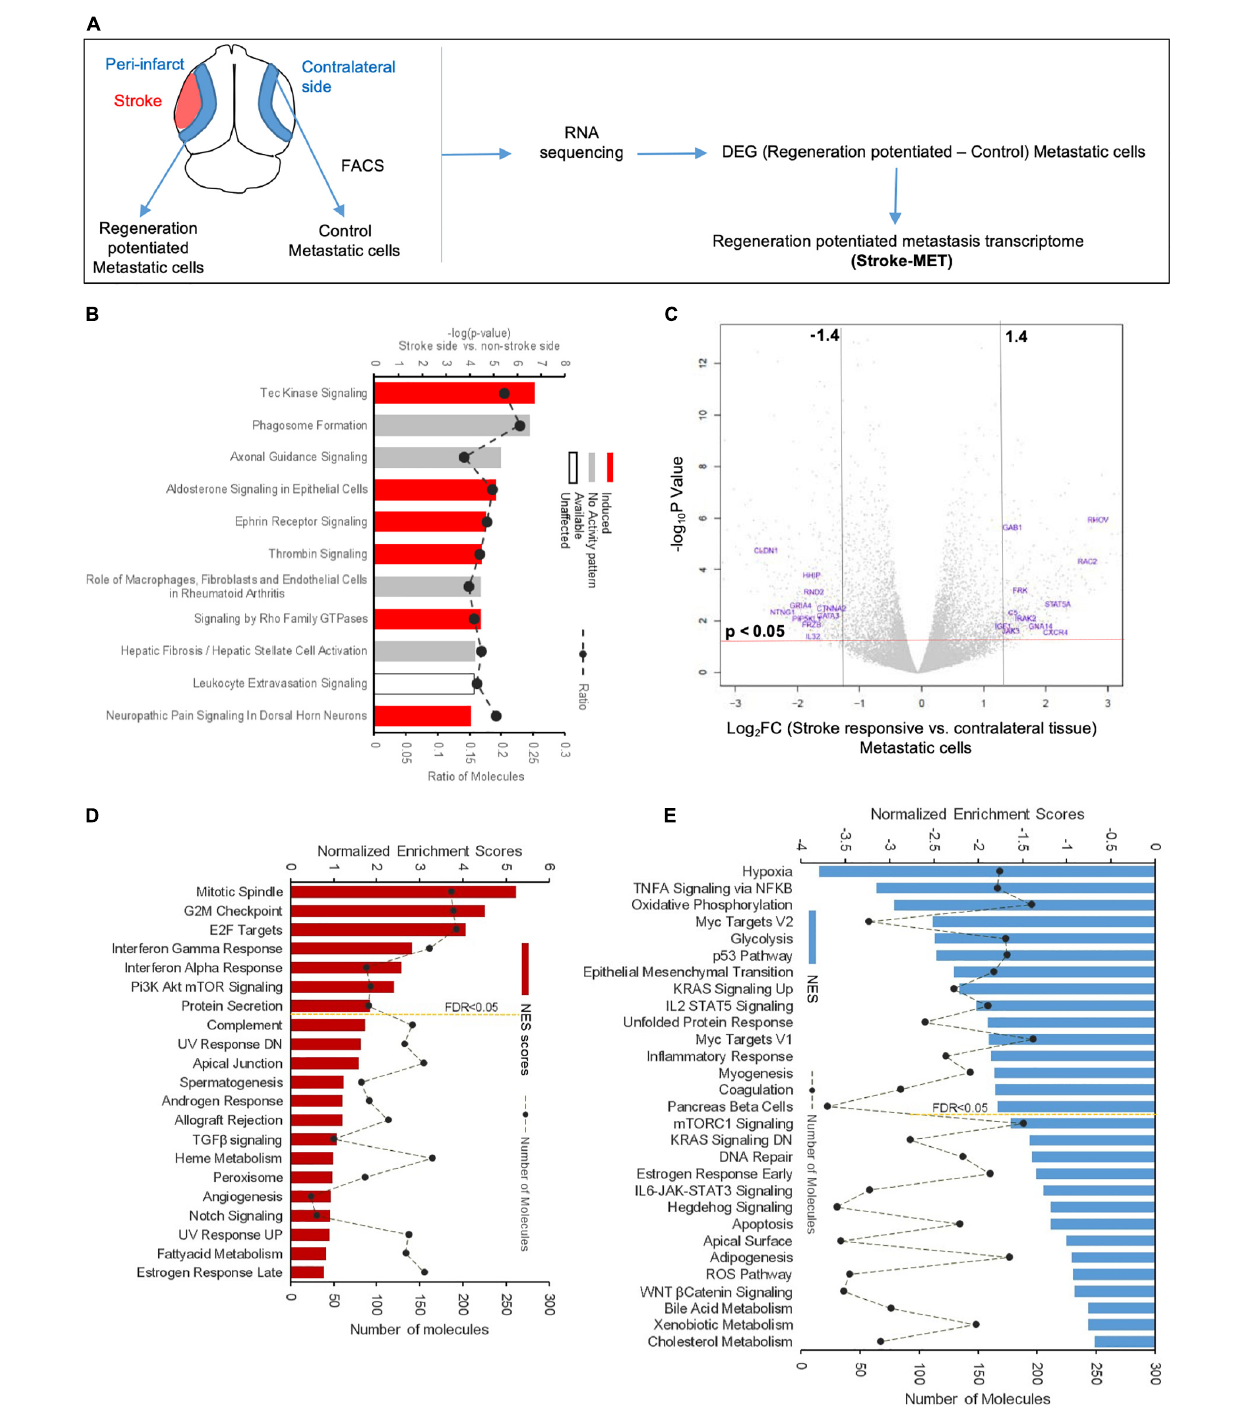
FIGURE 6 | Molecular signaling systems in regeneration-potentiated brain metastasis. (A) Schematic representation of flow of transcription profiling and regenerative neurovascular niche components interacting with metastatic cells. Significant and differentially expressed genes between regeneration-potentiated and contralateral metastatic cells as determined by log 2 fold change > 0.5 and p < 0.05 (Stroke-MET). (B) Top differentially regulated canonical pathways with largest negative logP shown in metastatic melanoma cells from the regenerative neurovascular niche compared to contralateral tissue. The dashed line represents the ratio of the number of molecules in the dataset over the number of molecules in the pathway. (C) Volcano plot showing p -values correlated with log 2 fold change in metastatic cells isolated from regenerative neurovascular niche vs. contralateral side. Genes systematically identified from top pathways from (B) , are marked in blue. (D,E) GSEA of hallmark genes up and downregulated in the Stroke-MET transcriptome. Estimated probability of FDR < 25% represent 3 / 4 chances of a gene set being valid.